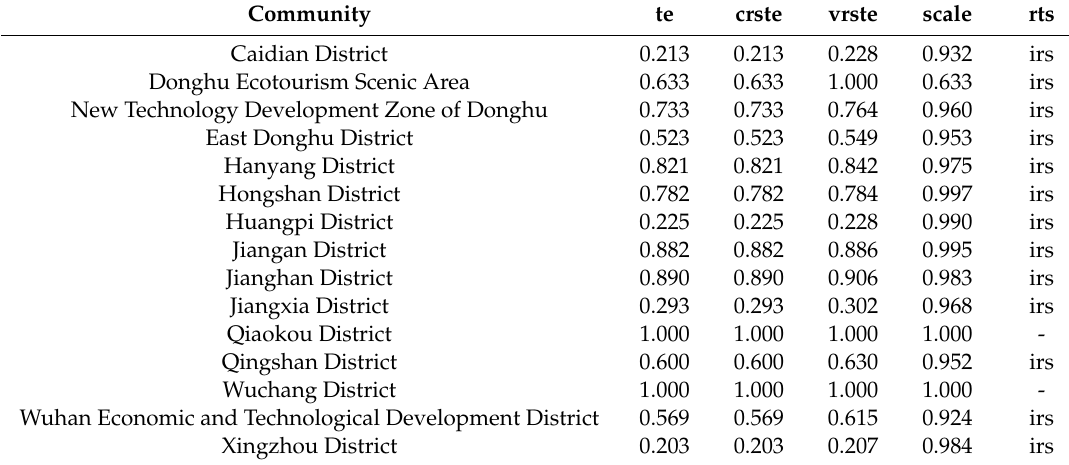
Table 2. Results of the DEA e ffi ciency evaluations about communities in Wuhan in the early stages. Community te